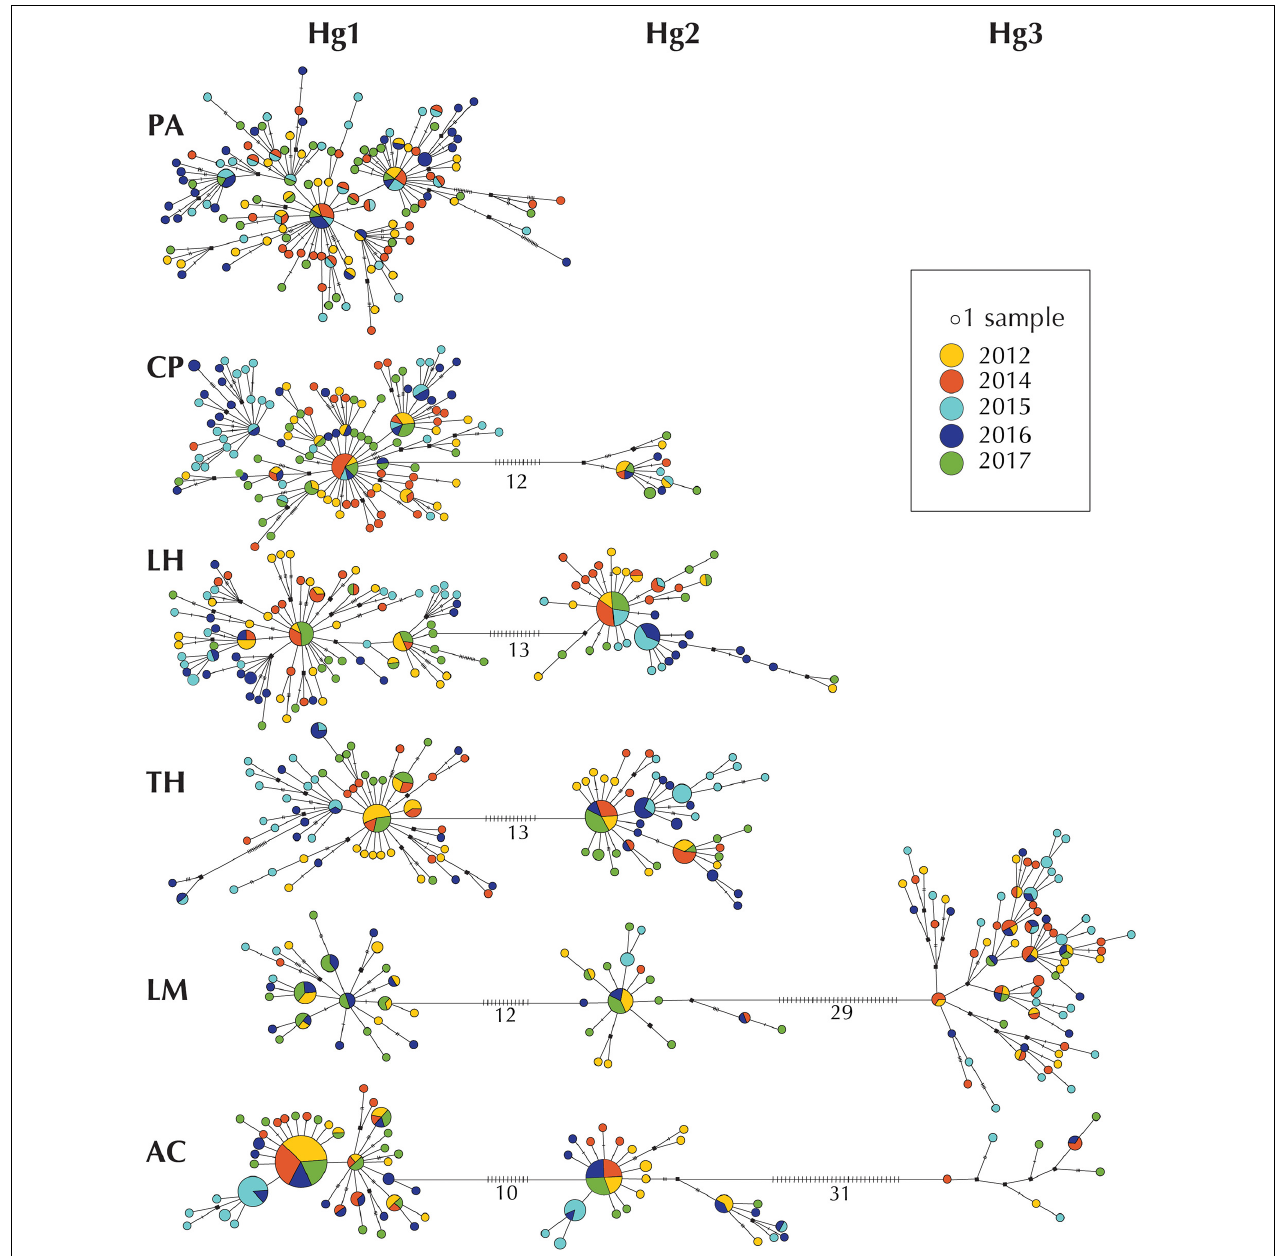
FIGURE 3 | Haplotype networks per location of COI haplotypes of Pyura chilensis . Each circle represents a sampled haplotype, and the size is proportional to the number of individuals with the haplotype. Colors represent temporal samples (years 2012, 2014, 2015, 2016, and 2017). Lines between haplotypes represent a mutational step, and small crossed lines correspond to additional steps. Hypothetic/non-sampled haplotypes are represented with a black square. The three COI haplogroups (Hg1, Hg2, and Hg3) are shown in a single network per site and numbers represent the number of mutational steps between